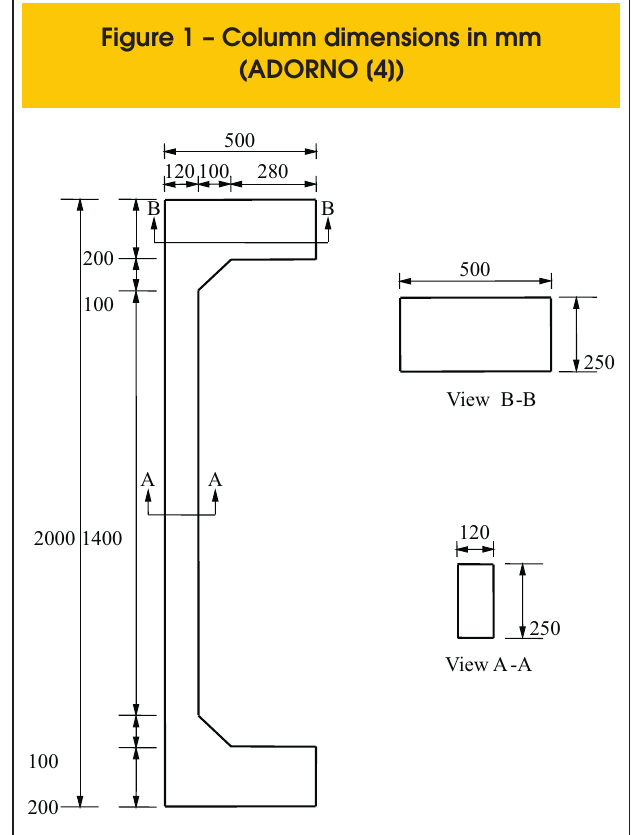
Figure 1 – Column dimensions in